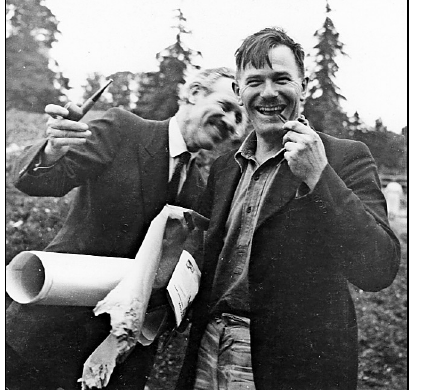
Figure 5 Sheppard Frere and